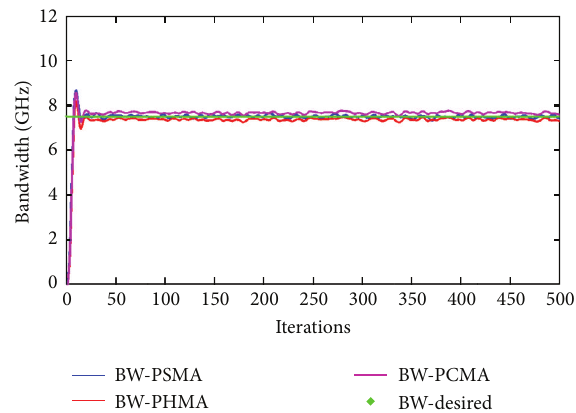
Figure 5: Optimized values of bandwidths for PSMA, PCMA, and